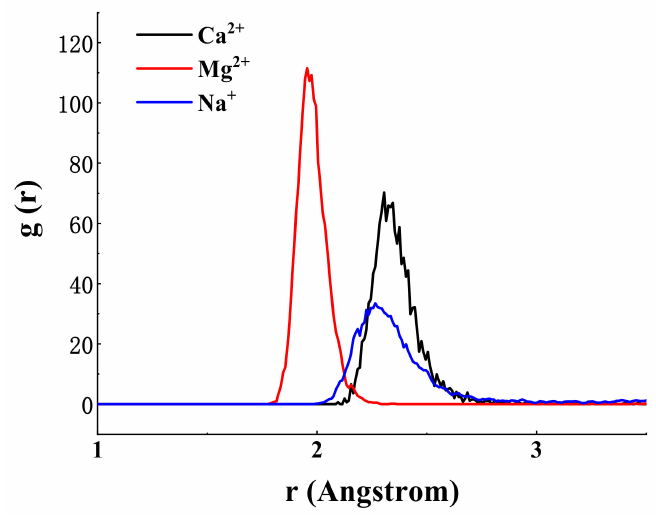
Figure 13. RDF of water and cations in APG foams (In hydration